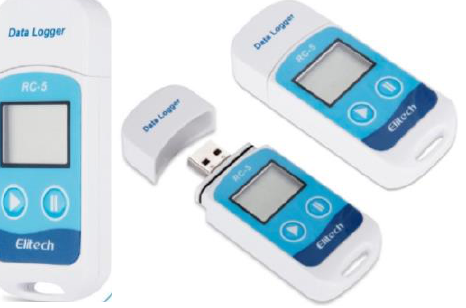
Setting the record interval